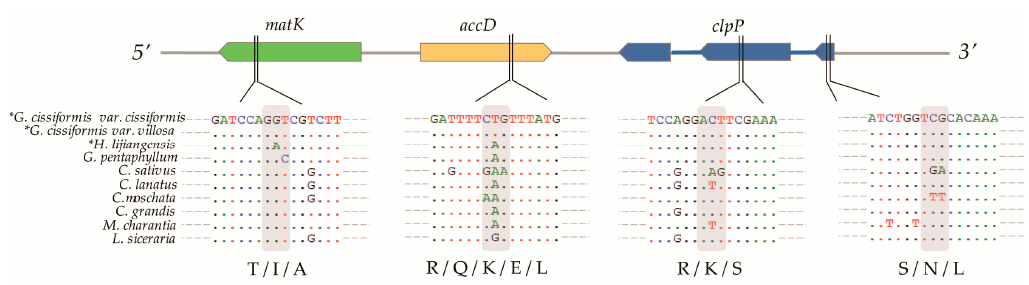
Figure 6. Alignment of selective sites of 10 Cucurbitaceae species. * marked three newly obtained CPGs.